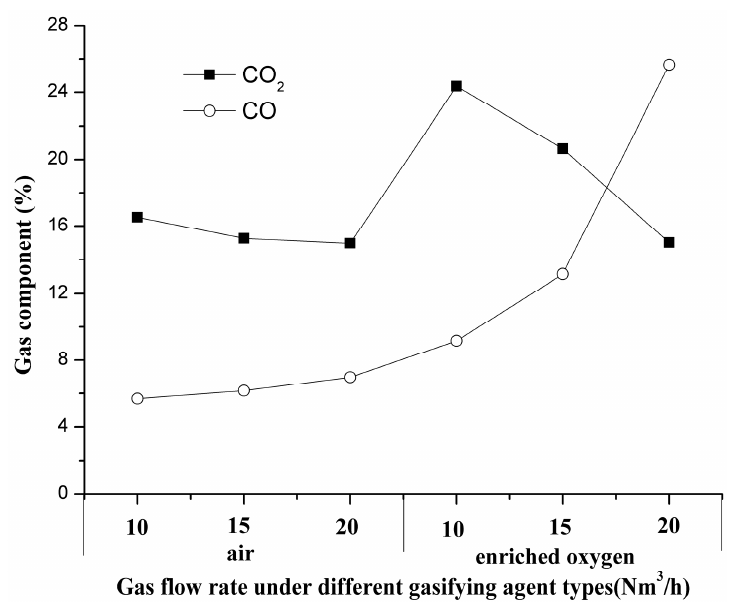
Figure 8. The gas components in the oxidation zone with air and enriched oxygen as the gasifying agent at different flow rates during the reverse UCG process.